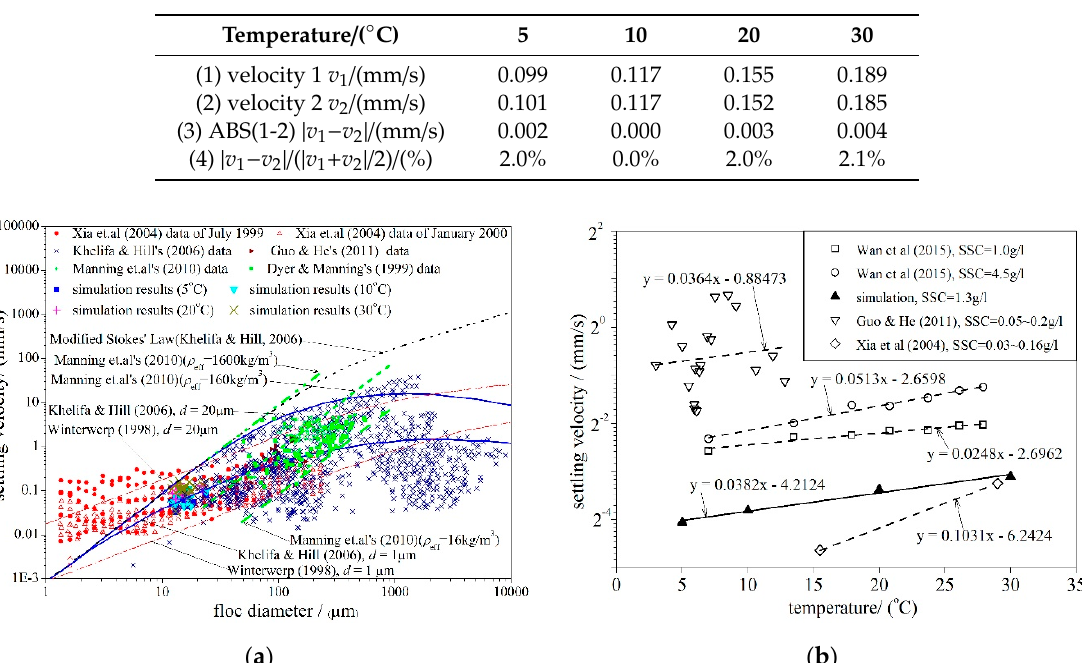
|/ ( | v + v |/ 2) represents − v 1 2 1 2